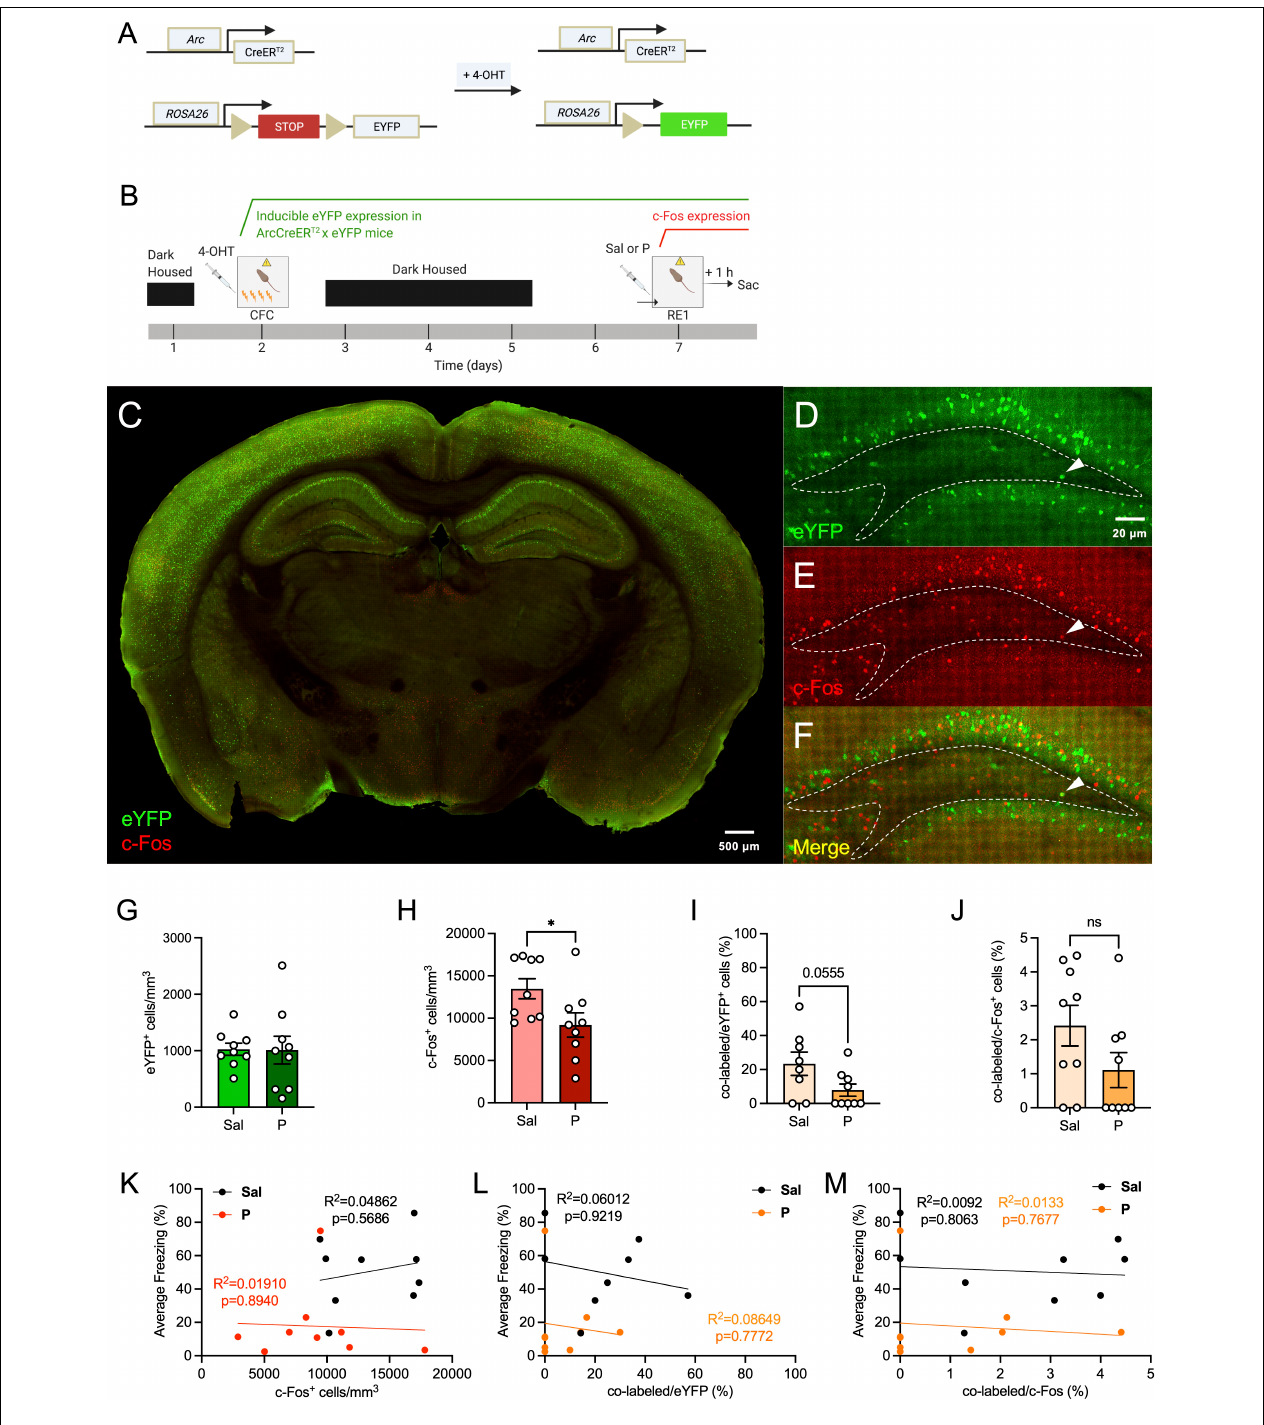
FIGURE 1 | Propranolol administration decreases hilar neural activity in the dorsal hippocampus. (A) Genetic design. (B) Experimental design. 4-OHT was administered 5 h before CFC for neural tagging. Five days later, mice were given an injection of saline or propranolol. Immediately following the injection, mice were re-exposed the fear context and euthanized 1 h later. (C) Representative section showing eYFP (green) and c-Fos (red) expression throughout the brain in the ArcCreER T2 × eYFP mice. (D) eYFP + , (E) c-Fos + , and (F) co-labeled cells in the dorsal hilus. Representative hilar sections are outlined in white. (G) eYFP + , (H) c-Fos + , (I) co-labeled/eYFP (%), and (J) co-labeled/c-Fos + (%) hilar cell counts. Correlation plots of average freezing vs. (K) c-Fos + cells, (L) co-labeled/eYFP + (%), and (M) co-labeled/c-Fos + (%). Error bars indicate ± SEM. ∗ p < 0.05, ∗∗ p < 0.01, ∗∗∗ p < 0.0001. eYFP, enhanced yellow fluorescent protein; 4-OHT, 4-hydroxytamoxifen; CFC, contextual fear conditioning; RE, context re-exposure; sac, sacrifice; Sal, saline; P, propranolol.